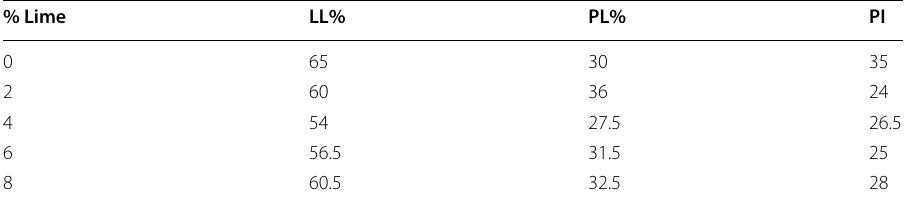
Table 3 Variation of Atterberg’s limit for soil SE treated with lime and cured for 7 days % Lime